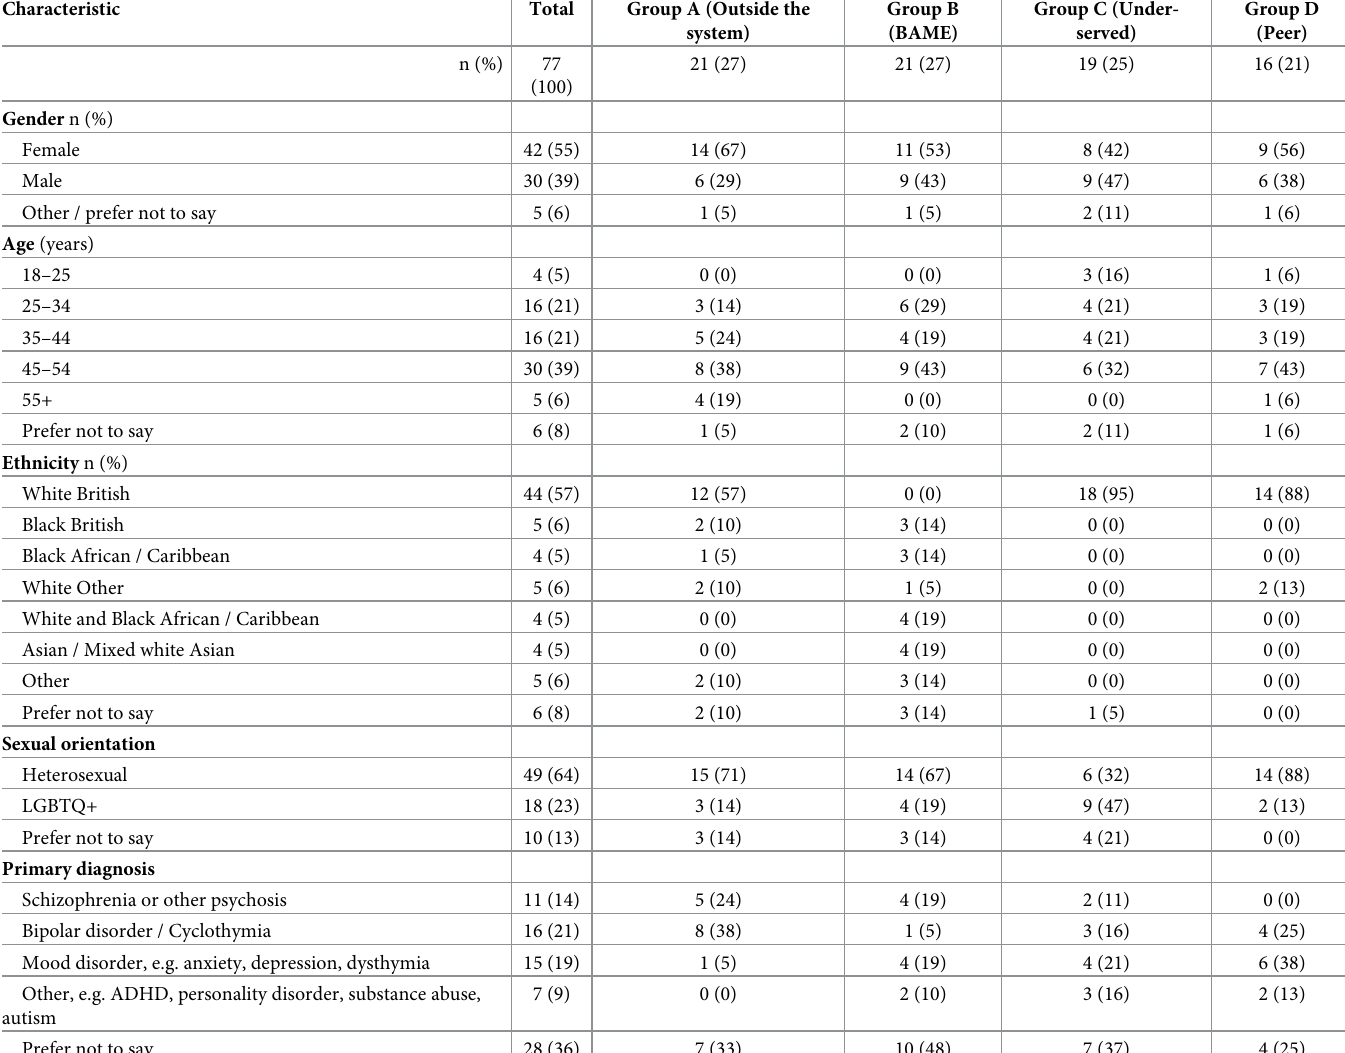
Table 1. Clinical and sociodemographic characteristics of participants (n =